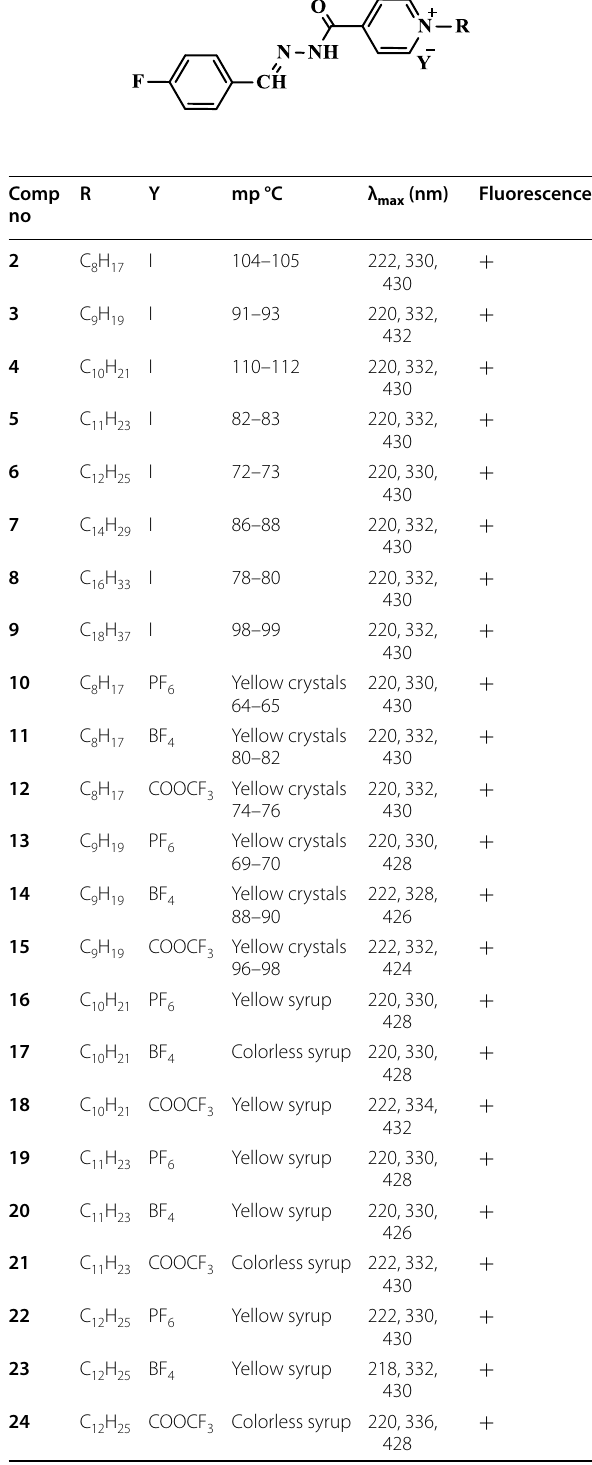
Table 3 Physical and analytical data for the newly synthesized pyridinium hydrazones